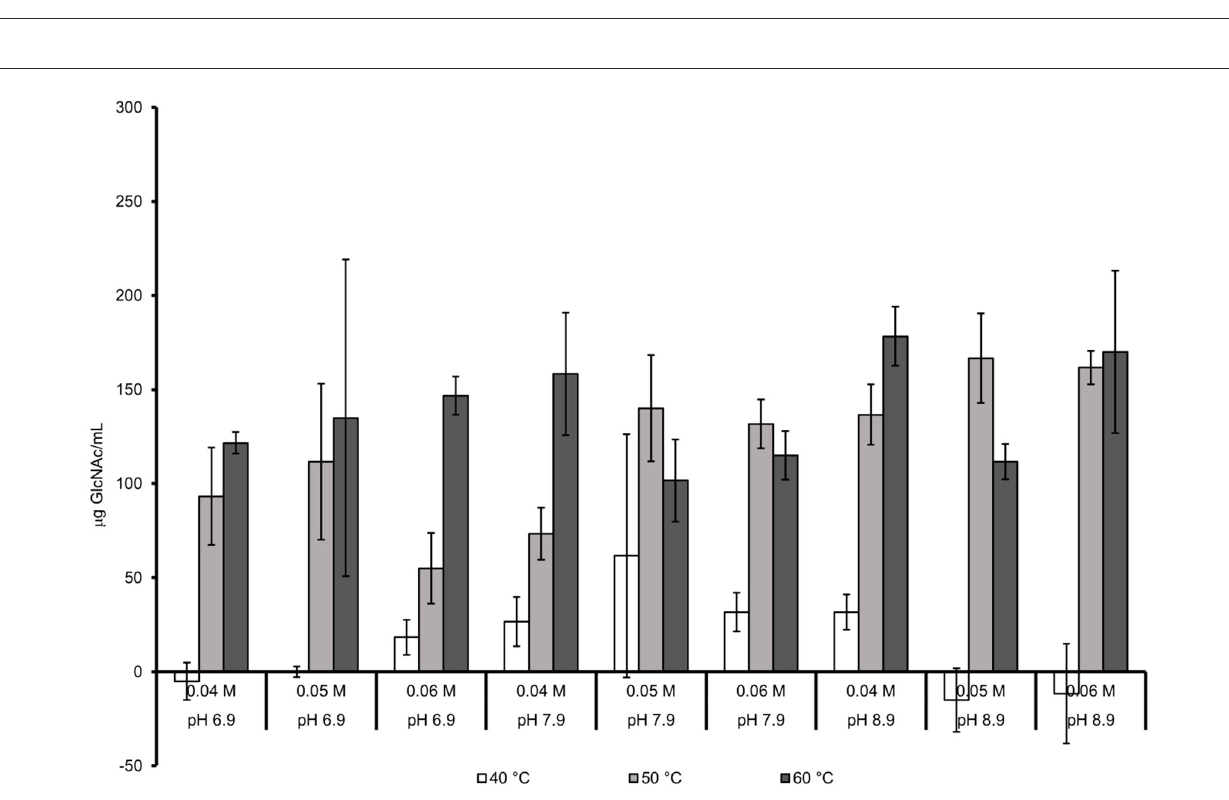
FIGURE3 Joint effect of temperature, pH, and buffer molarity in absence of